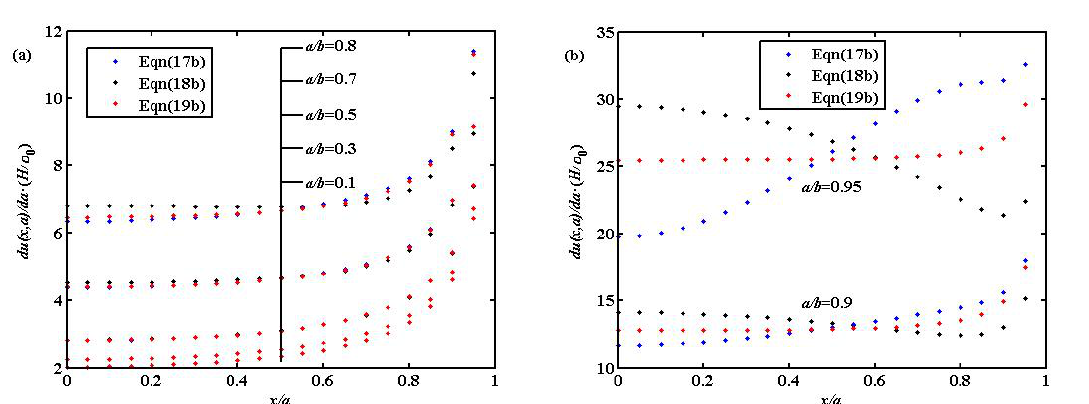
Figure 2: Dimensionless partial derivatives of collinear cracks (a) 0 ≤ a / b ≤ 0.8; (b) 0.95 ≥ a / b ≥